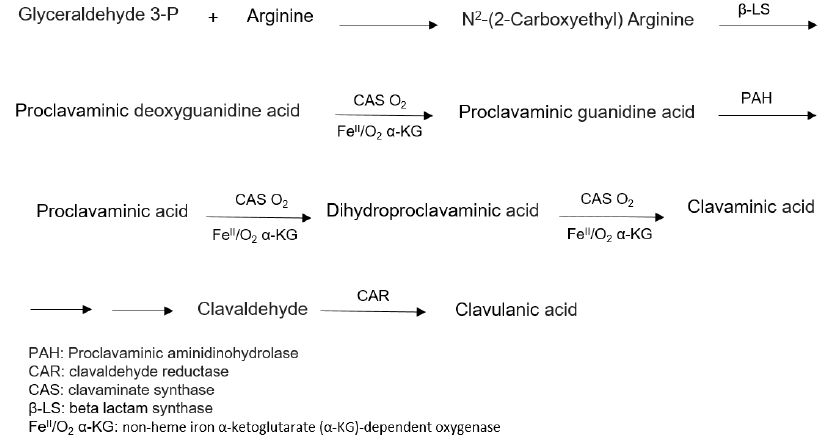
Figure 4. Scheme of clavulanic acid biosynthesis. (Adapted from Oliveira et al. [89,90]).